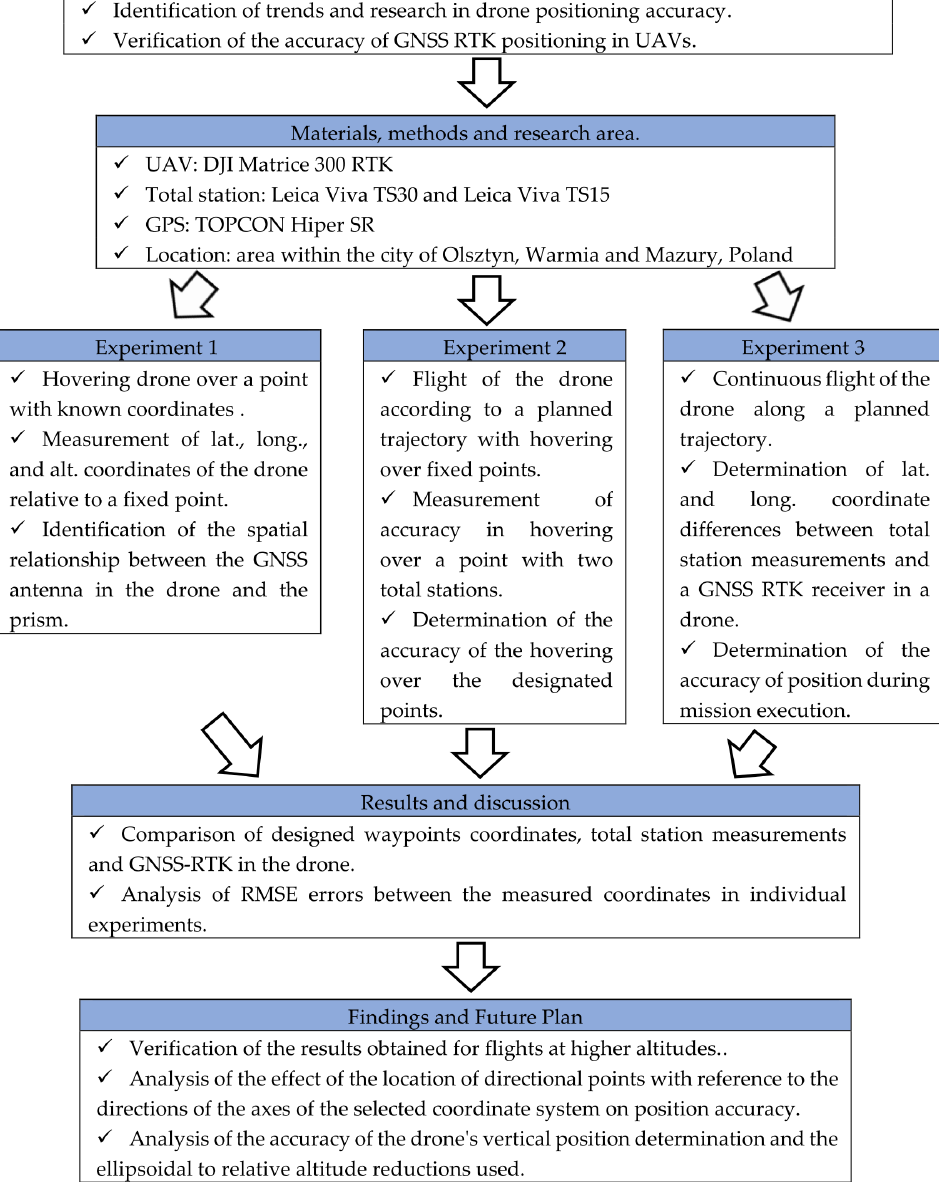
F igure 5. Overview of study procedure. Figure 5. Overview of study